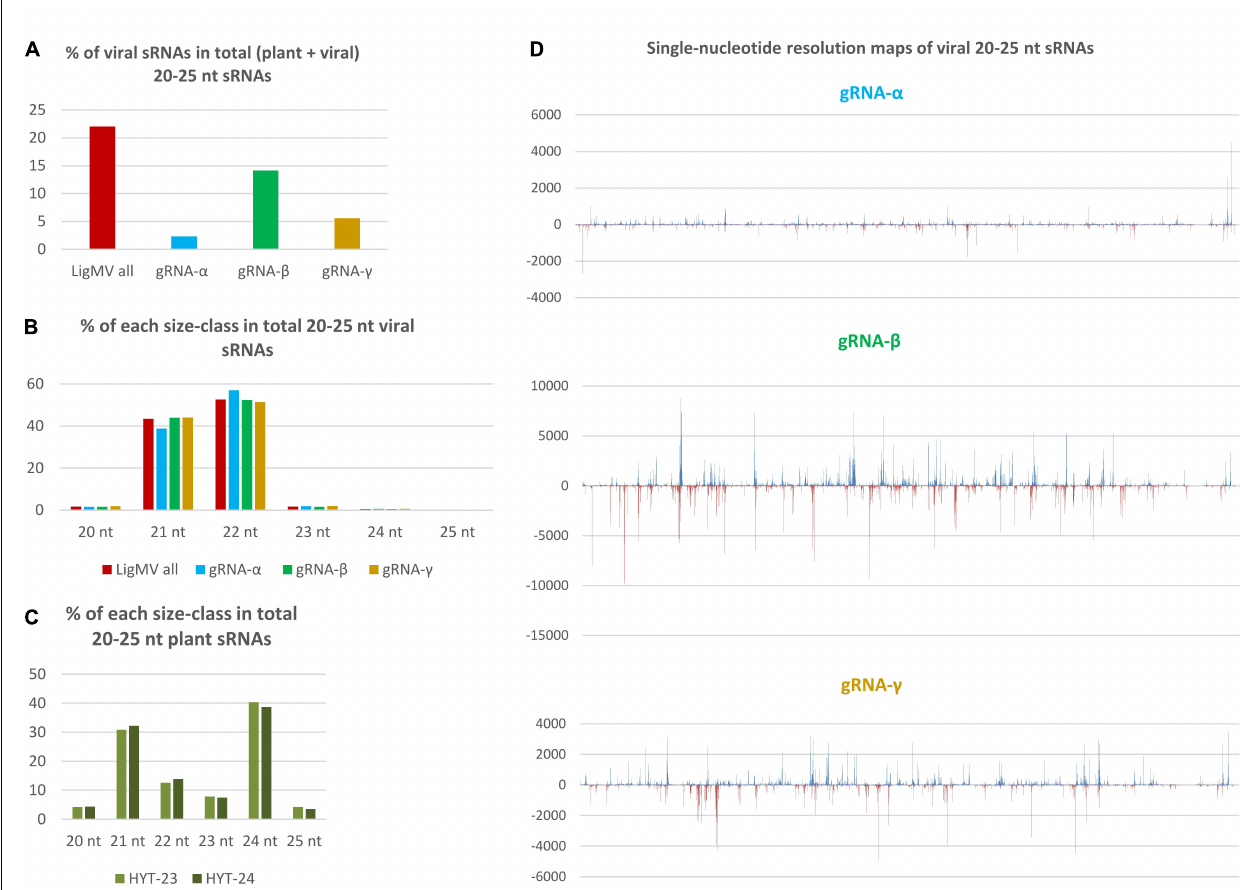
FIGURE 7 | Illumina sequencing analysis of viral and host small RNAs from ligustrum mosaic virus (LigMV)-infected and healthy Ligustrum vulgare plants. Small RNA (sRNA) fractions of total RNA extracted from healthy (HYT-23) and LigMV-infected (HYT-24) leaf samples were converted to cDNA and Illumina sequenced. Then, 20–25 nt reads representing the majority in each library ( Supplementary Dataset 2 ) were mapped on the reference sequences of LigMV gRNA segments α , β and γ with zero mismatches and counted. The bar graphs in (A–C) represent the percentage of viral genome-derived sRNA reads in total (plant + viral) 20–25 nt reads and their distribution between the three gRNA segments (A) , the relative abundance of each sRNA size-class in total 20–25 nt viral reads for the complete virus genome and each gRNA segment (B) and the relative abundance of each sRNA size in total 20–25 nt plant (non-viral) reads from the healthy and virus-infected plants (C) . (D) Shows single-nucleotide resolution maps of 20–25 nt viral sRNAs generated by MISIS-2 (Seguin et al., 2016) for each gRNA segment (see Supplementary Dataset 3 for each size-class). Forward and reverse strand-derived viral sRNAs are represented in blue and red,